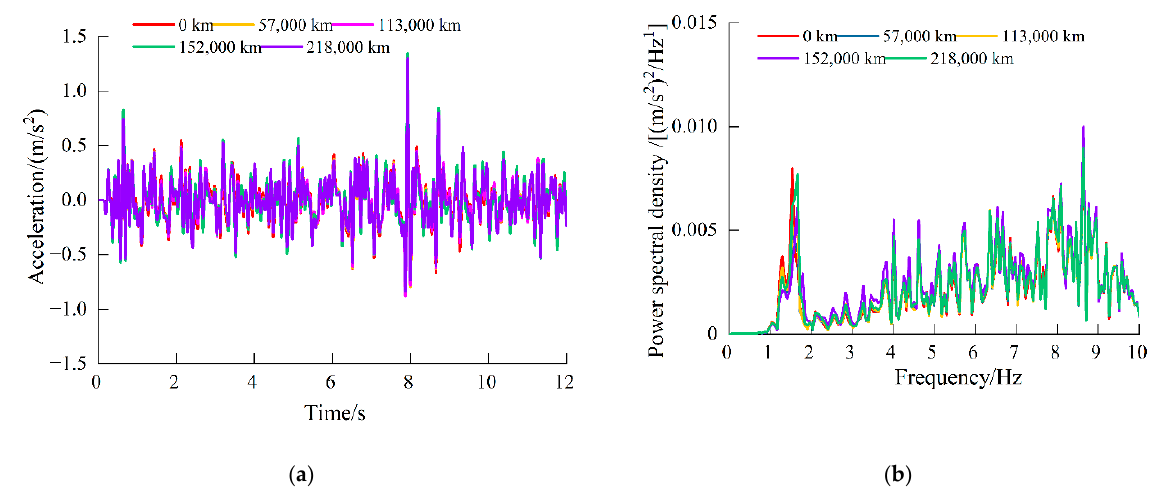
Figure 14. Vibration on bogie frame ends for Line B: ( a ) time-domain and ( b ) frequency-domain.